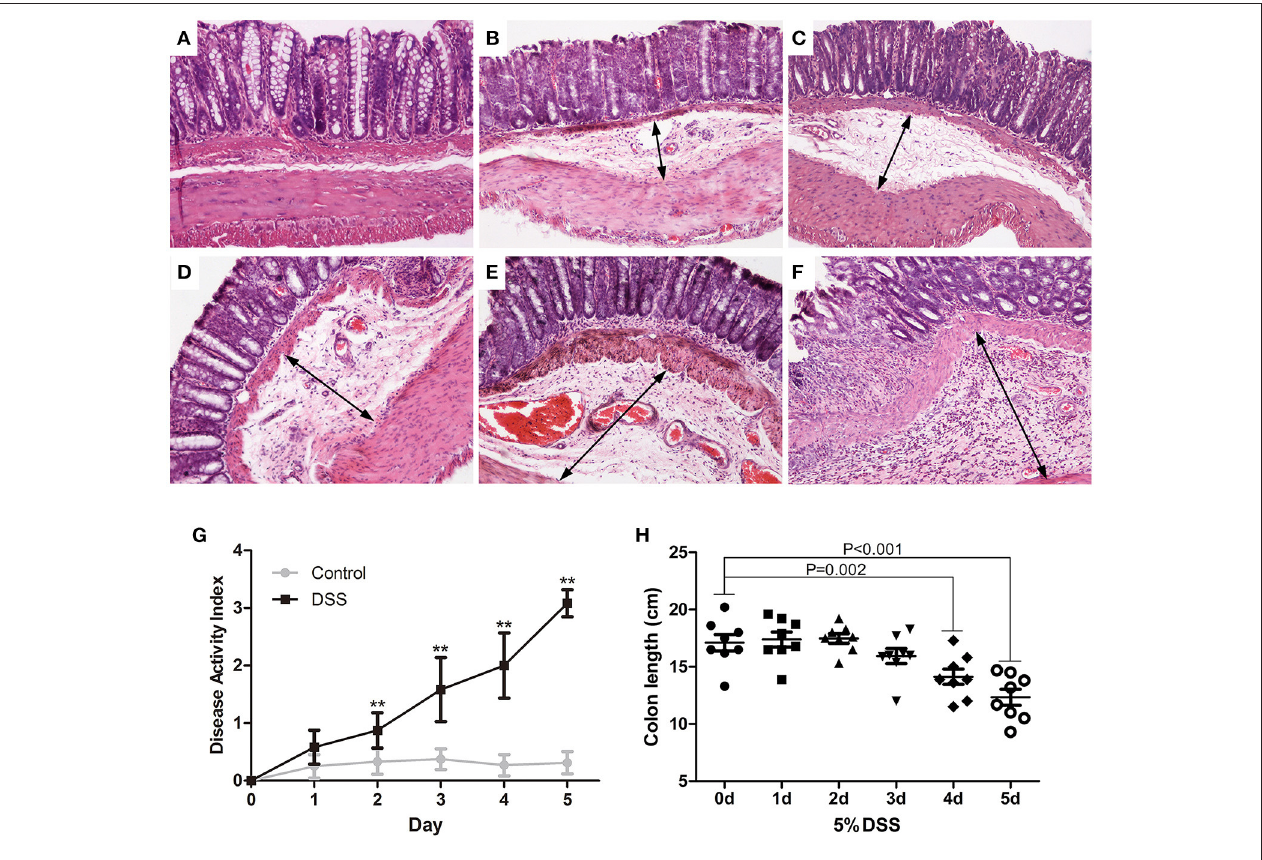
FIGURE 2 | Dynamic pathological changes of the distal colon in DSS models of UC. Paraffin sections of the distal colon were stained with HandE ( A : DSS 0 d; B : DSS 1d; C : DSS 2 d; D : DSS 3 d; E : DSS 4 d; F : DSS 5 d) (HandE staining, × 100). DAI (G) was assessed daily and colon length was measured on day 5 (H) . Data were expressed as mean ± SD ( n = 8–10), * P < 0.05, ** P < 0.01 vs. control group or vs. 0 d group.